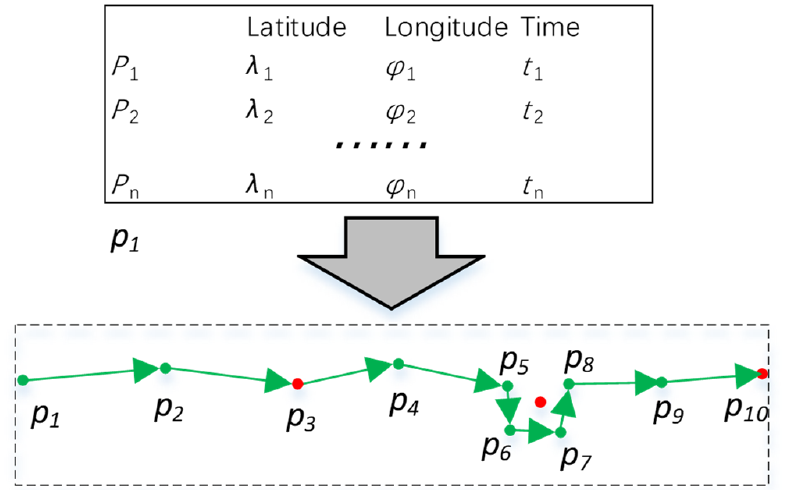
Figure 4. GPS records and stay points. A trajectory is composed by some line segments, green arrows represent their direction, the green dots are the sample points of the trajectory. The red dots represent the identified stay points